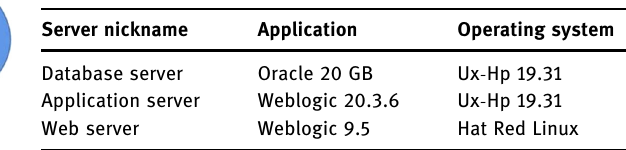
Table 2: Software con fi guration